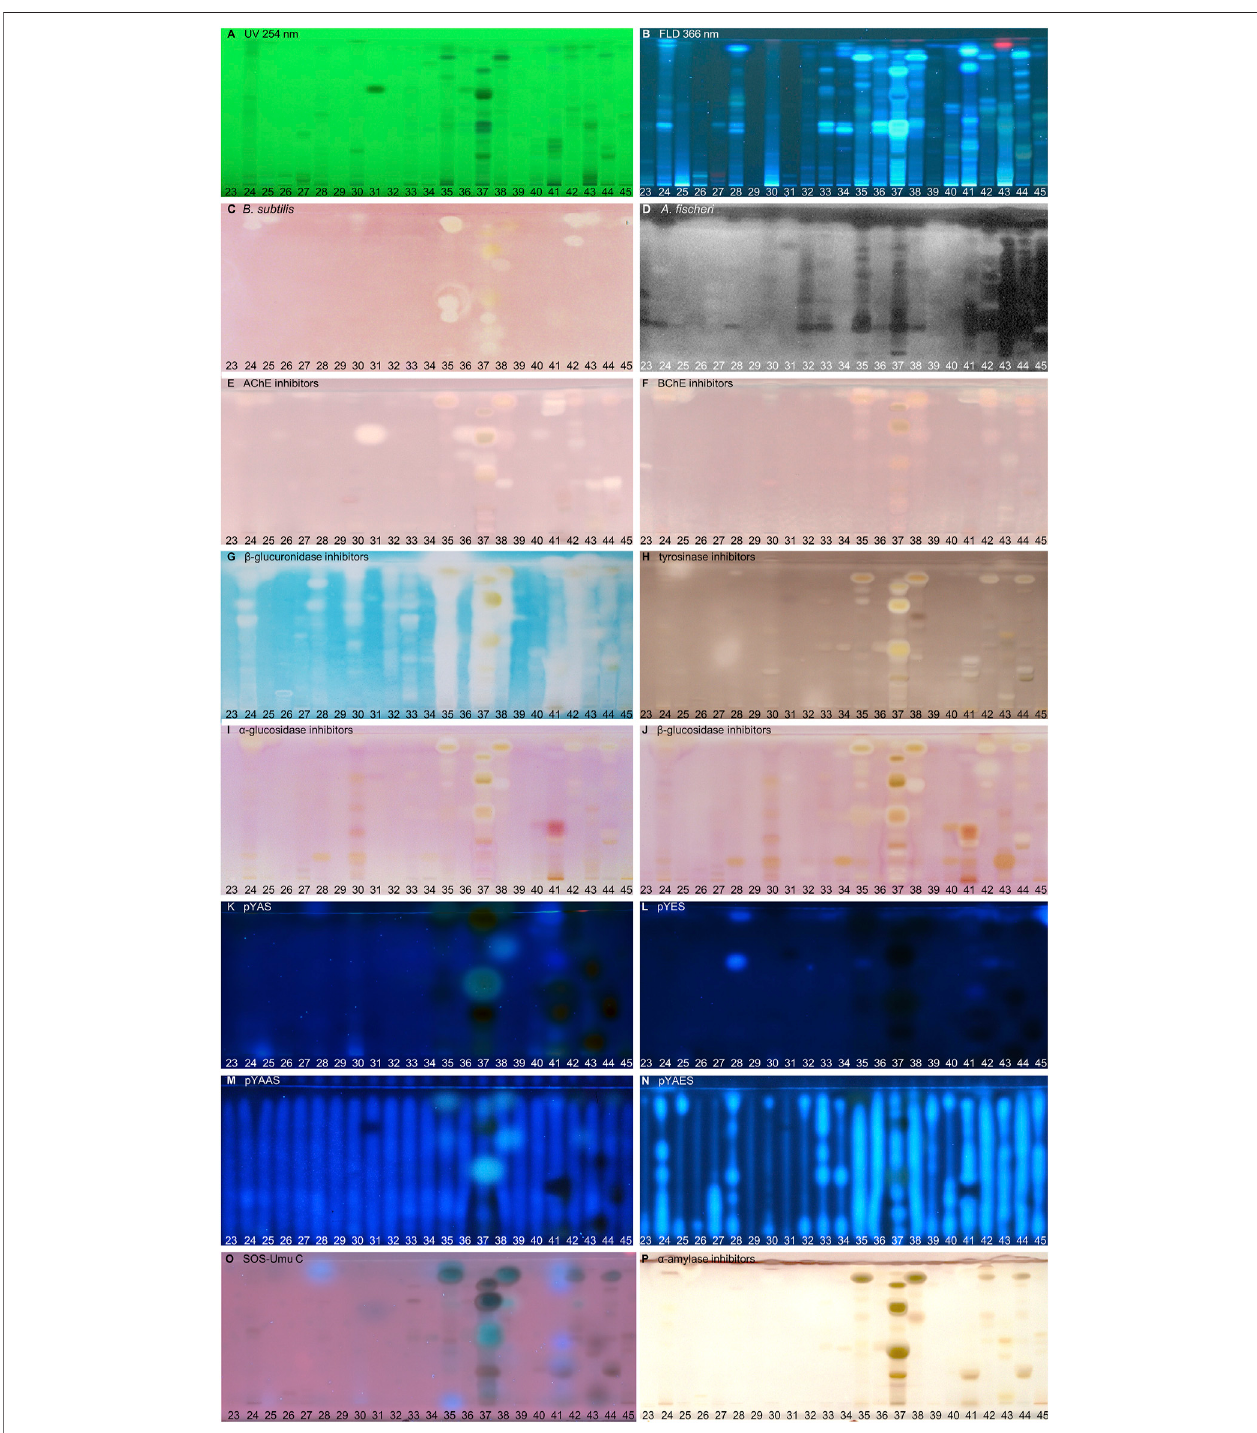
FIGURE 3 | NP-HPTLC − UV/Vis/FLD − EDA pro fi les of the plant extracts no. 23 – 45. Separation of the applied botanicals (4 µL/band, assignments in Table 1 ) on HPTLCplatesilicagel60F 254 MS-gradewithethylacetate — toluene — formicacid — water(16:4:3:2, V/V/V/V )upto70 mm,detectedatUV254 nm (A) ,FLD366 nm (B, K – O) andwhitelightillumination (C,E – J,P) afterthe B.subtilis bioassay (C) , A. fi scheri bioassaywithbioluminescencedepictedasagreyscaleimage, (D) andAChE (E) , BChE (F) , β -glucuronidase (G) ,tyrosinase (H) , α -glucosidase (I) , β -glucosidase (J) ,and α -amylase (P) inhibitionassays,aswellaspYAS (K) ,pYES (L) ,pYAAS (M) , pYAES (N) , SOS-Umu-C (O) bioassays.